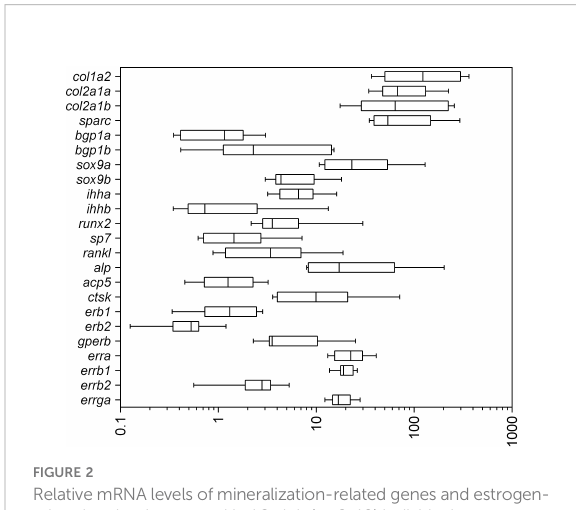
FIGURE 2 Relative mRNA levels ofmineralization-related genes and estrogen- related endocrine control in 16-dph (n=8-10) individuals maintained in controlrearingconditions (second cohort). Relative mRNA levels are expressed as DD Cpwith the bgp1a gene used as a reference. In boxplots, hinges indicate fi rst and thirdquartiles; whiskersindicate the min and max values, and horizontal lines indicate the